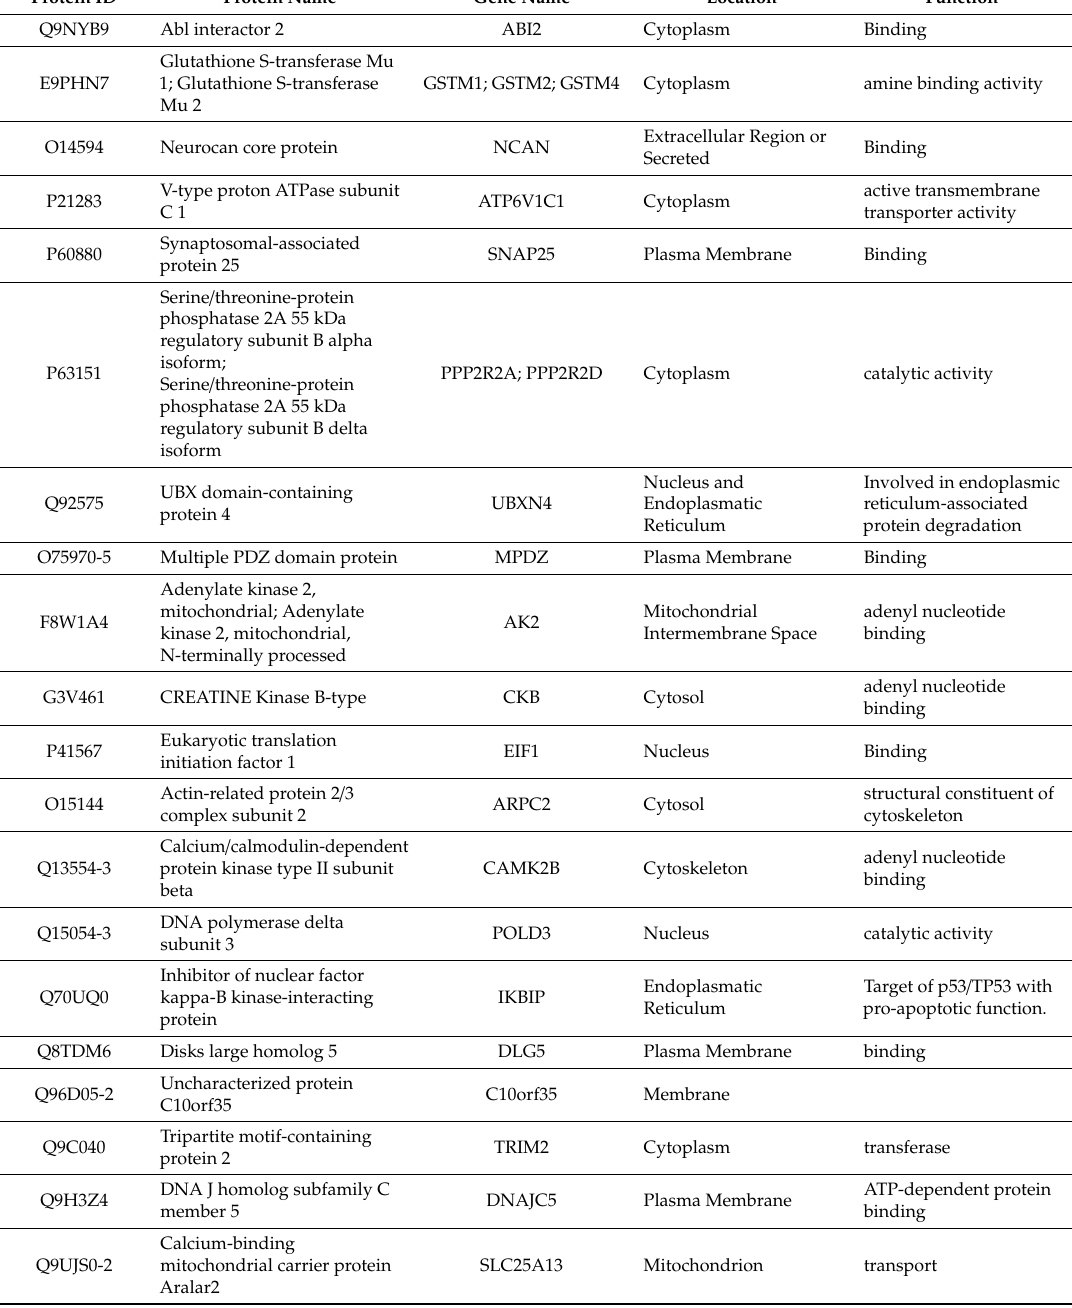
Table 1. Name, cellular location and function of proteins exclusively present in RBT derived